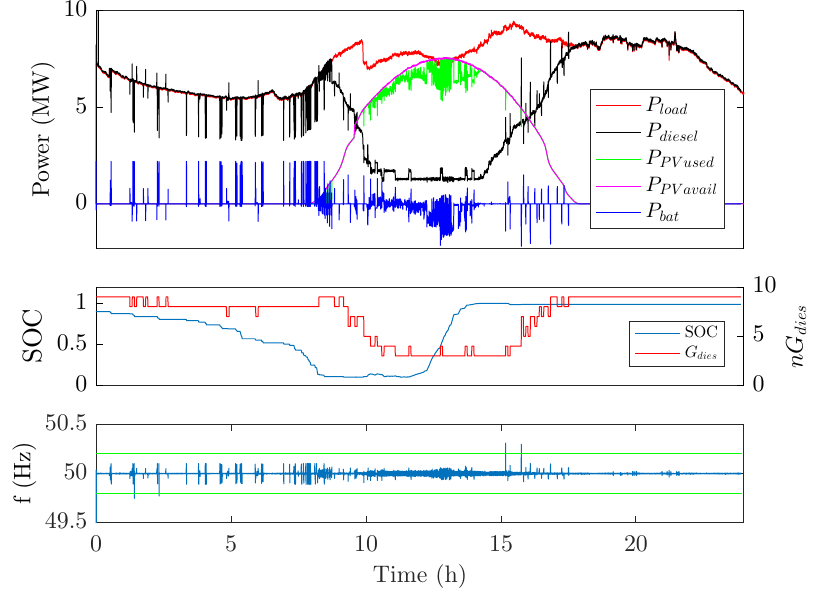
Figure 8. Simulation results for the third scenario (low PV